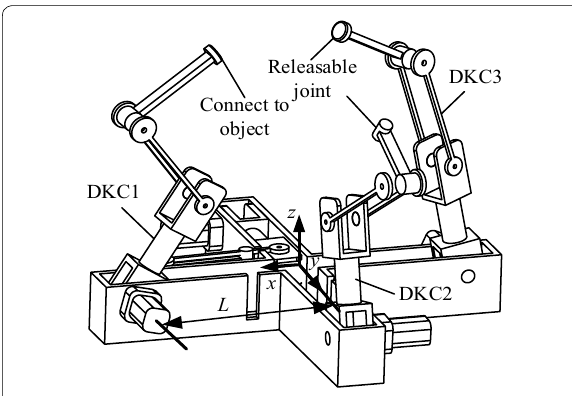
The coordinate system O - xyz is established at the center of the platform as shown in Figure 18. The dis- tance between point O and the axle of the first joint is L . The structure parameters of DKC are shown in Figure 19. In DKC1, while using the D-H coordinate transformation method, each D-H parameter is as listed in Table 2. According to Figure 19, the transformation matrix from point O to releasable joint is: